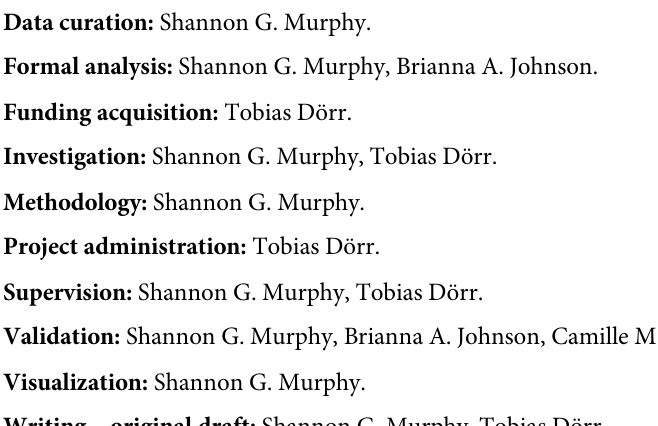
S2 Table. Genes differentially expressed in a V . cholerae strain overexpressing VerA. Tran- script abundances in a strain overexpressing VerA (VC0513) relative to an empty-vector con- trol were measured using RNA-seq (see Methods for details). Gene ID’s and descriptions [82] are shown for all significant (adjusted p-value < 0.05) differentially expressed (log 2-fold change > 1) genes. S3 Table. Summary of strains and oligos used in this study. Strains used in this study are listed with unique identifiers (SGM-#). For E . coli donor strains, the primers or gene block used to construct each plasmid are listed in the “Oligos” column. Genetic changes introduced into V . cholerae were screened using the method indicated in the “confirmation” column: either via PCR using the indicated primers (SM-#), via purification on kanamycin plates, or via blue-white screening on X-gal